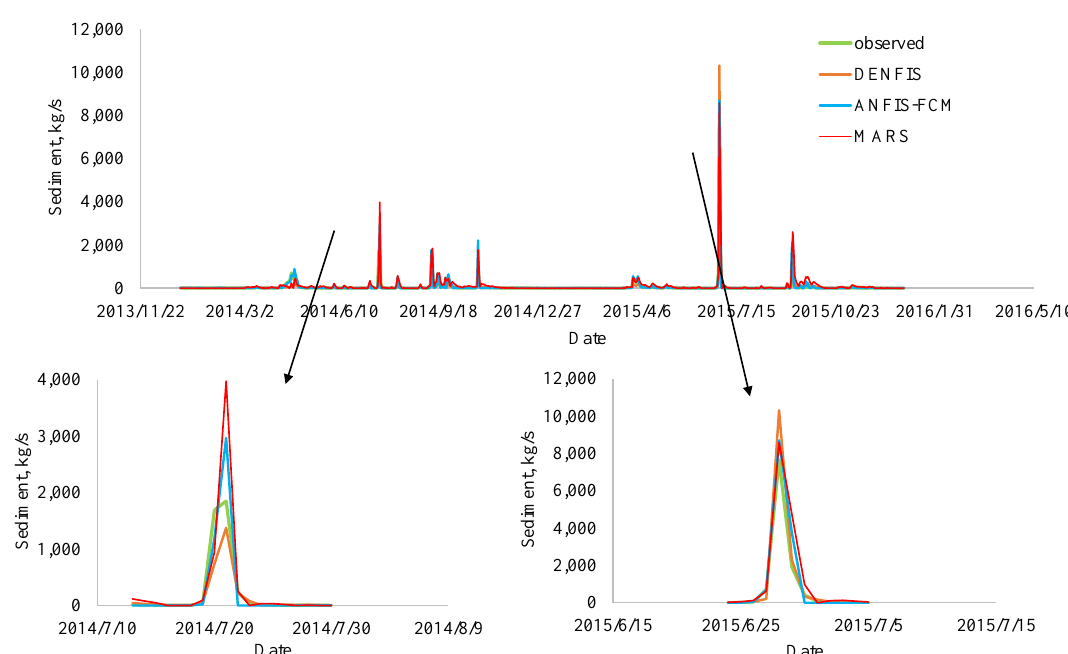
Figure 5. Time variation graphs of the observed and estimated suspended sediment by DENFIS, ANFIS-FCM and MARS in the test period at Guangyuan Station. R² = 0.9199